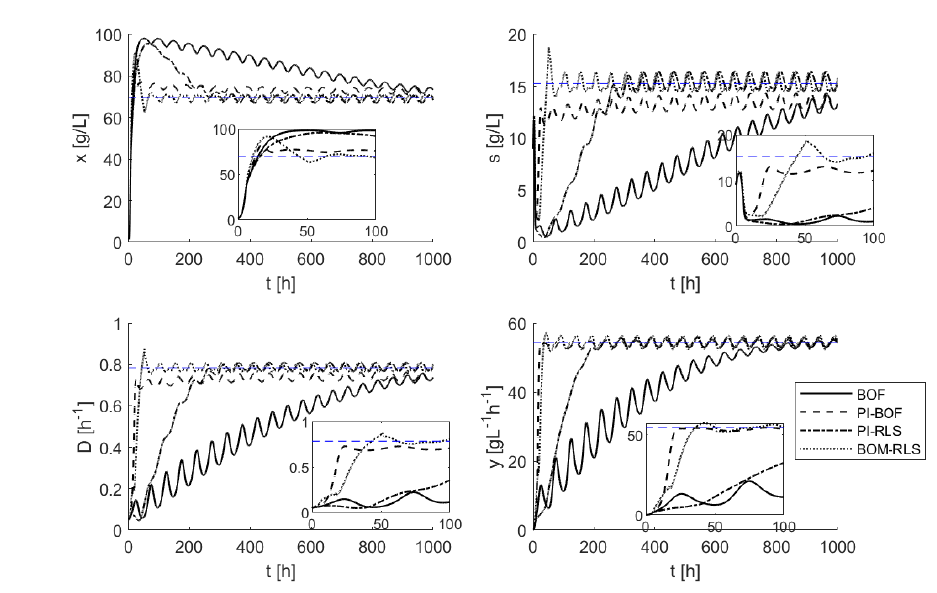
Figure 8. Application of the BOF, PI-BOF, PI-RLS, and BOM extremum seeking methods to optimize biomass productivity of microbial growth represented by model (3) with Monod kinetics—state, input, and output time evolutions.